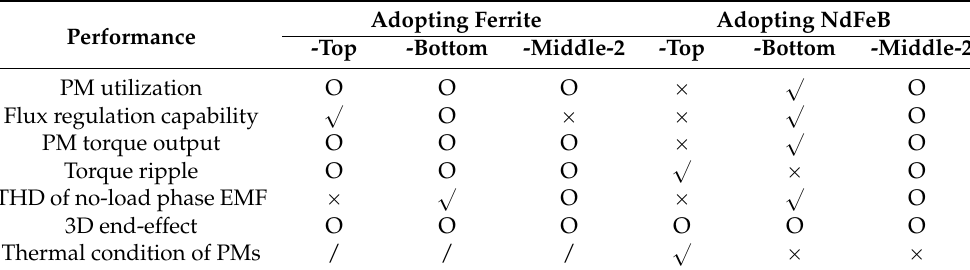
Table 8. Comprehensive